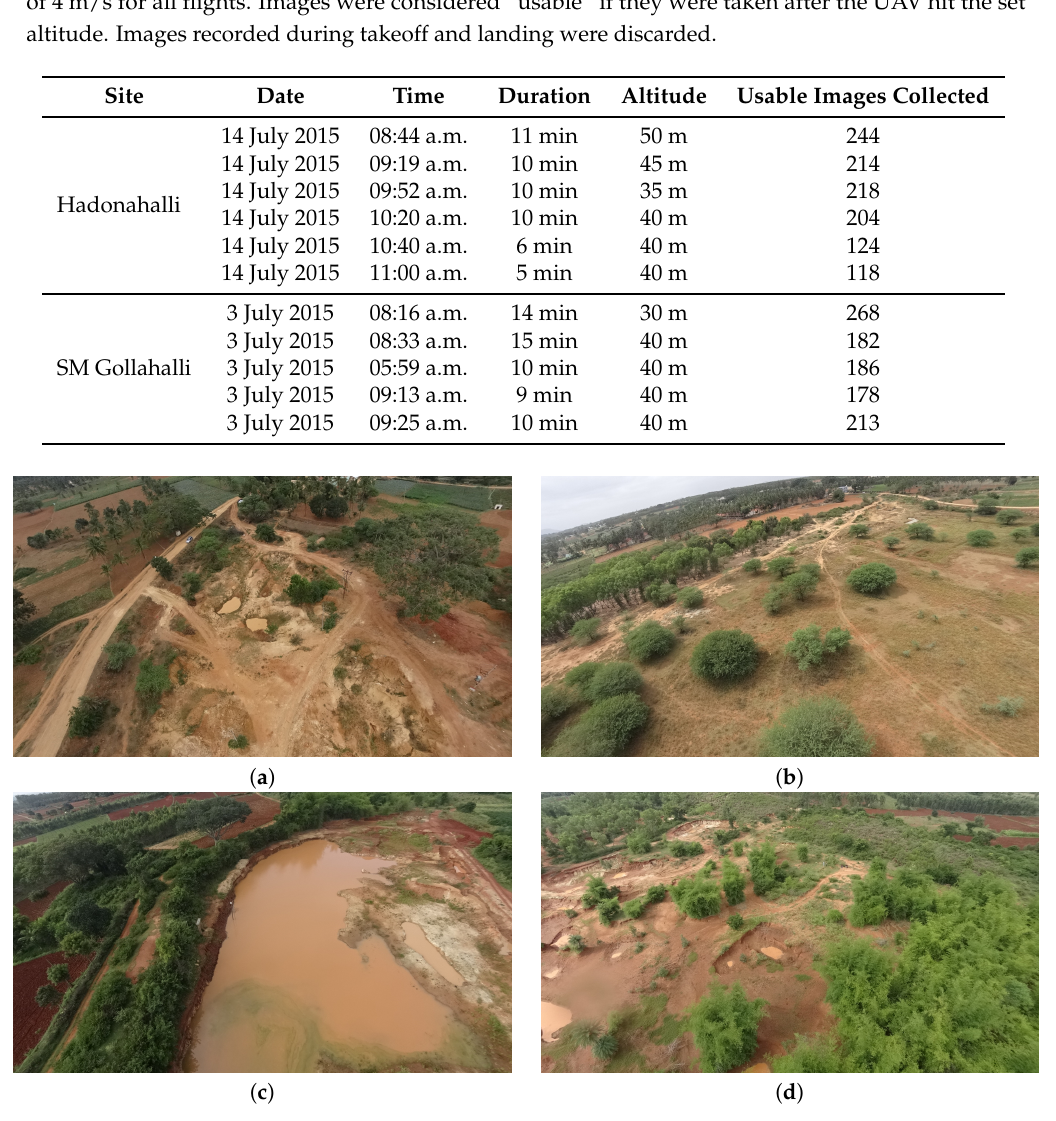
Figure 5. Representative sample of tank aerial images: ( a ) immediate tank area of Hadonahalli where pockets and sharp changes in elevation were prevalent; ( b ) expansive, flat region surrounding the immediate tank in Hadonahalli (also referred to as the tank “spread area”); ( c ) submerged immediate tank area of SM Gollahalli; and ( d ) SM Gollahalli tank spread